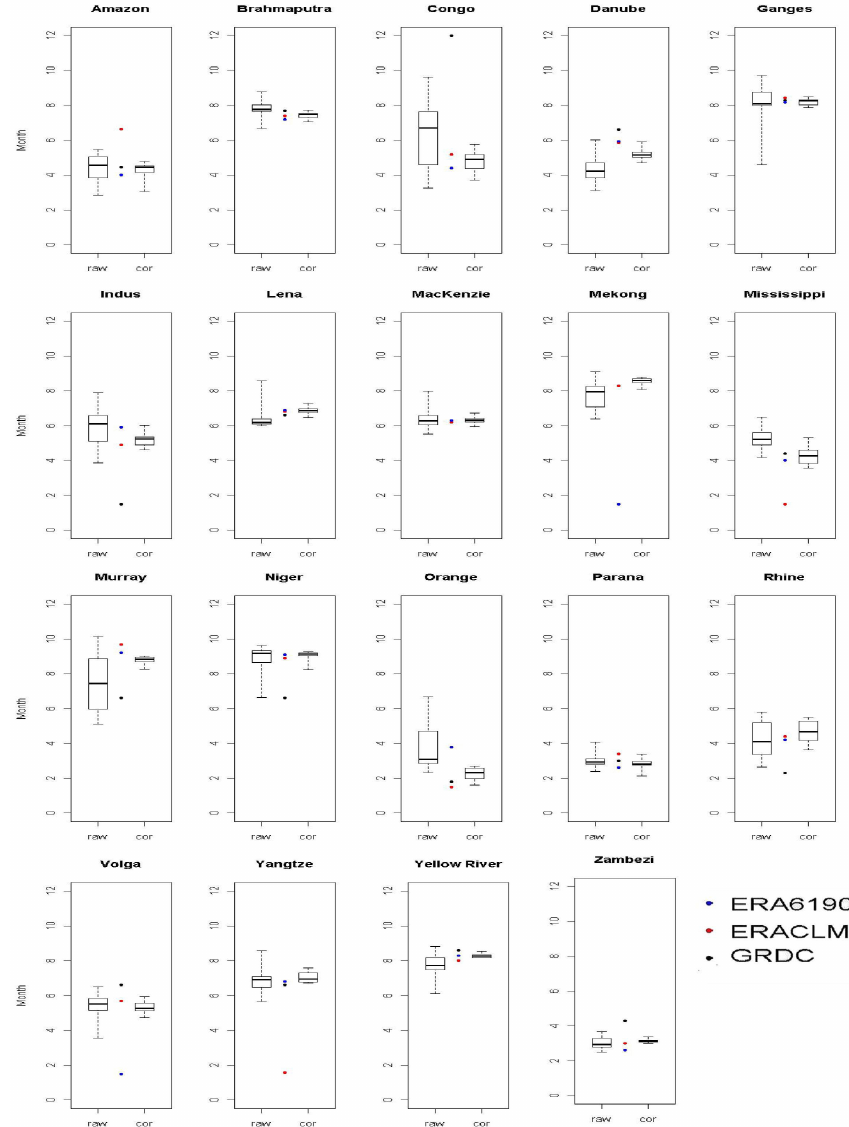
Figure 6: Thirty year average month of peak discharge occurrence ( Qpeak (-) ) for the2 ensemble of non-bias corrected GCM runs (raw) and bias-corrected GCM runs (cor; boxes3 are drawn between the quartiles and whiskers represent minimum and maximum values), the4 ERA6190 run (blue points), the ERCLM run (red points) and the GRDC observations (black5